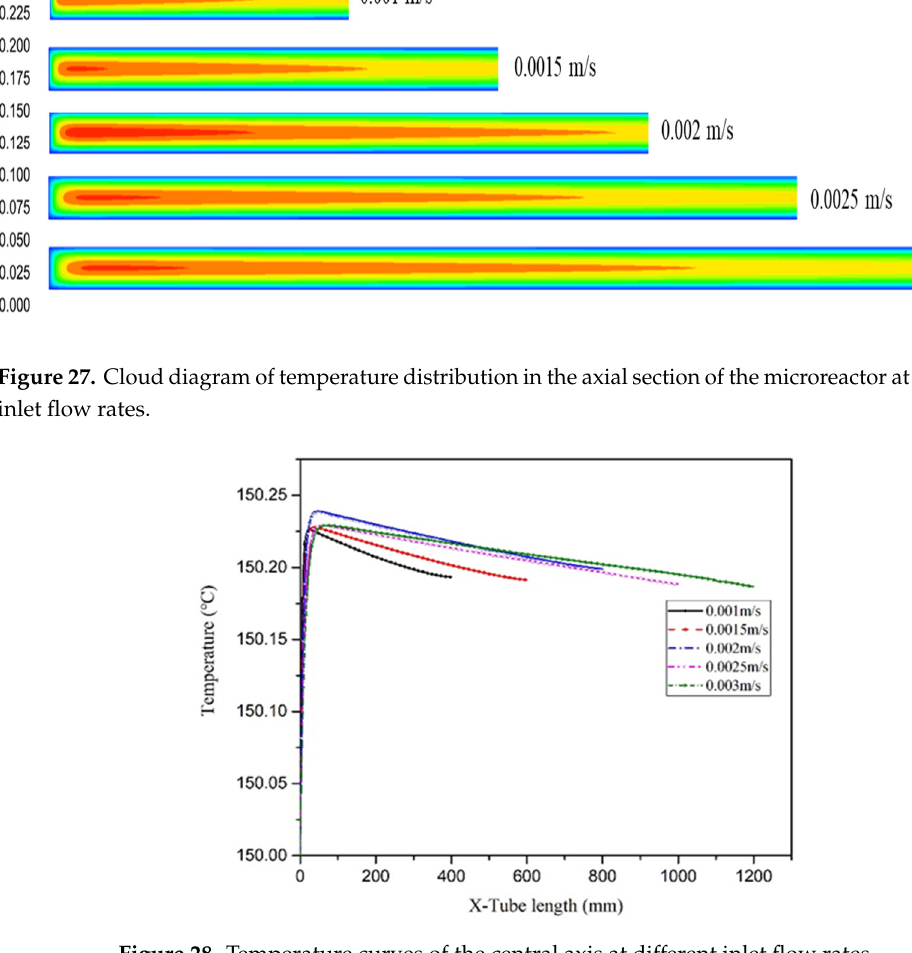
Figure 29. Viscosity curve in microreactor at different inlet velocities.